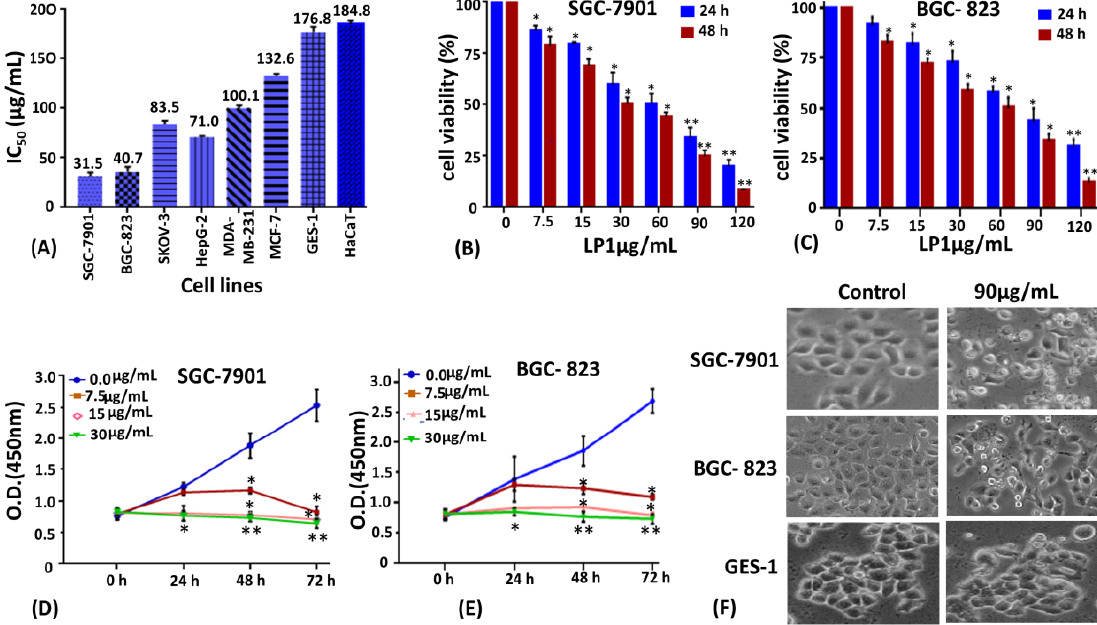
Figure 1. Effect of LP1 on the viability and proliferation of SGC-7901 and BGC-823 cells. ( A ) IC 50 values of LP1 against a panel of cancerous and non-cancerous cell lines were evaluated and results are expressed as means ± SD (Standard Deviation) of three independent experiments at 48 h. ( B ) SGC-7901 cells and ( C ) BGC-823 cells treated with different concentration of LP1 for 24 and 48 h, to determine cell viability by CCK-8. Results are expressed as a percentage of corresponding control and means ± SD of three independent experiments; (* p < 0.05, ** p < 0.01). ( D , E ) Cell proliferation assay performed by CCK-8, with a low dose of LP1 at different time intervals for SGC-7901 and BGC-823 cells. Results are presented as means ± SD of three independent experiments; (* p < 0.05, ** p < 0.01). ( F ) Morphological changes in SGC-7901, BGC-823 and GES-1 cell lines were observed under a phase contrast microscope after 48 h treatment with a mentioned concentration of LP1 at 40× magnification.